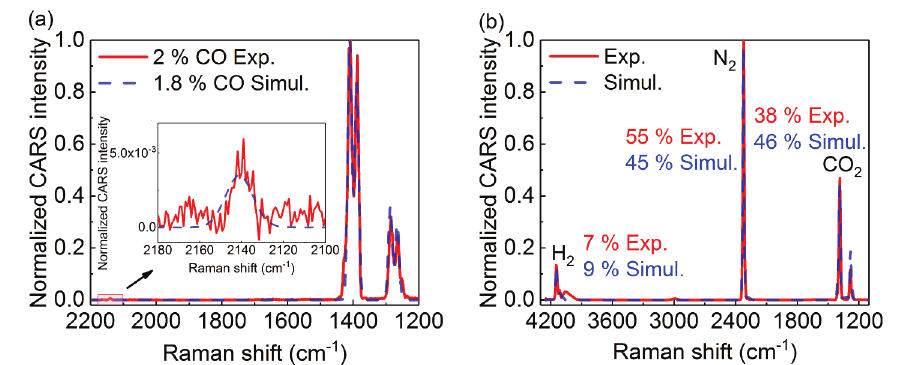
Fig. 2. Experimental and simulated fs-CARS spectra for concentration determination for (a) 2 % CO (simulated 1.8 %) in a CO-CO 2 gas mixture at 1073 K and 1.4 bar (b) gas mixture of 7 % H 2 , 55% N 2 , and 38% CO 2 (simulated 9 %, 45 % and 46 %, respectively, for H 2 , N 2 and CO 2 ) at 478 K and 1.4